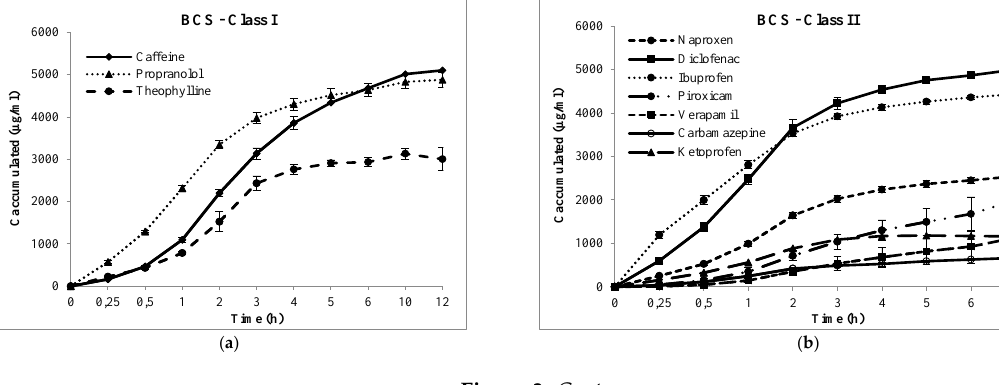
Figure 3 – Cumulative transport (µg/mL, h) of drugs across Bampa-Franz: a) BCS class I; b) BCS class II; c) BCS class III; and d) BCS class IV. Permeability was calculated from the linear portion (R 2 ). Data are presented as mean ± SD, n = 3